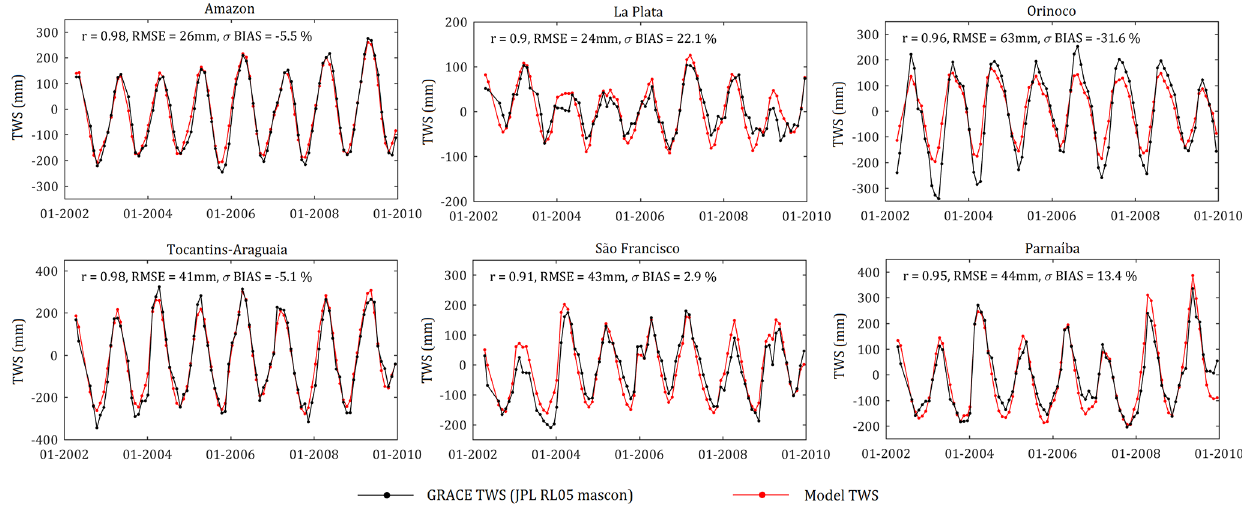
Figure 9. Comparison between MGB and GRACE (JPL RL05 v2 mascon solution) monthly TWS anomalies for major South American